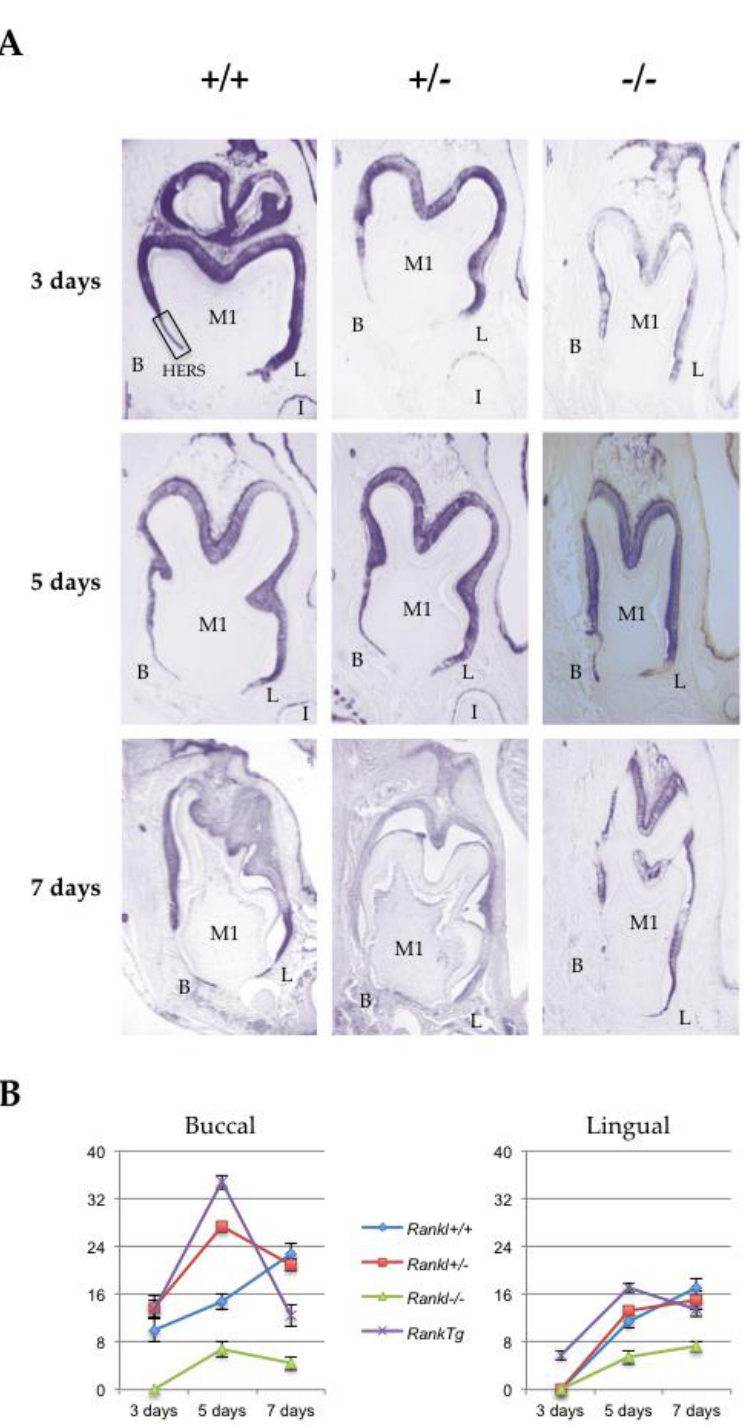
Figure 2. Comparative analyses of Hertwig’s epithelial root sheath length in the different Rankl genotypes based on keratin-14 immuno-staining. (A) Keratin-14 immunohistochemistry was performed on 5 µm thick frontal sections of the Rankl +/+ , Rankl +/- and Rankl -/- C57BL/6 mouse heads at the ages of 3, 5 and 7 days postnatal. At least five mice were analyzed for each genotype and at each age. The Rankl -/- sections revealed a significant reduction in the number of Hertwig’s epithelial root sheath cells with interruptions in sheath continuity by bone matrix deposition with a progressive invasion of the pulp. In the lingual ( L ) region, the sheath appeared less altered morphologically than in the buccal ( B ) region. Scale: 20X/100 µm. (B) Graphic representation of the quantitative analyses of Hertwig’s epithelial root sheath cell numbers in the buccal and lingual regions performed on the sections of Rankl +/+ , Rankl +/- and Rankl -/- C57BL/6 mouse heads at the ages of 3, 5 and 7 days postnatal.